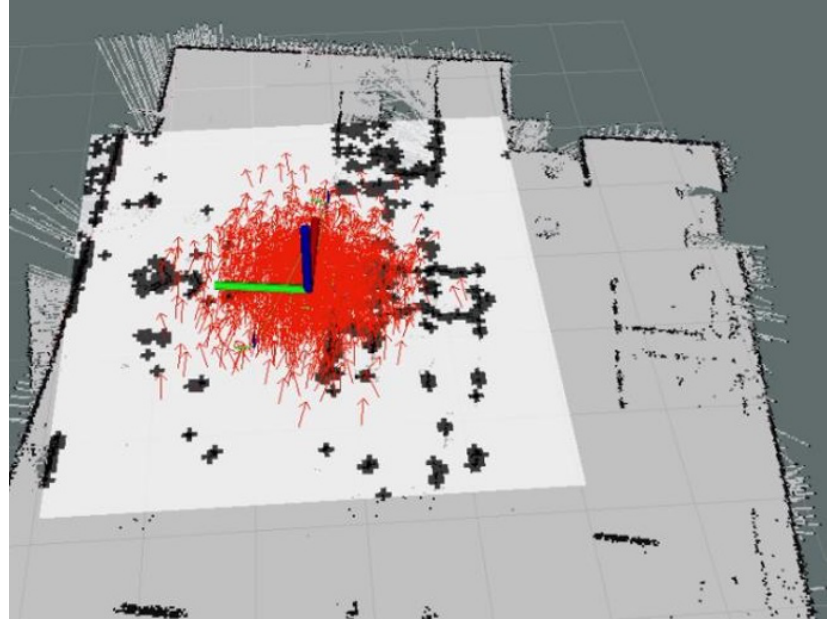
Fig. 7. A fragment of the system in autonomous